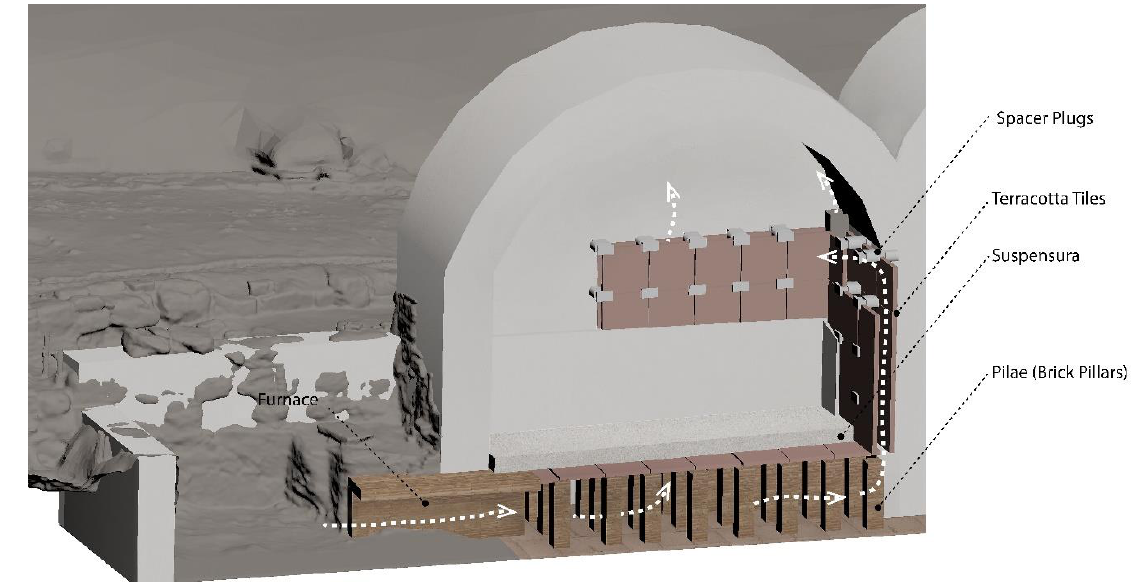
Figure 8. Virtual reconstruction of the bath, section of the praefurnium and